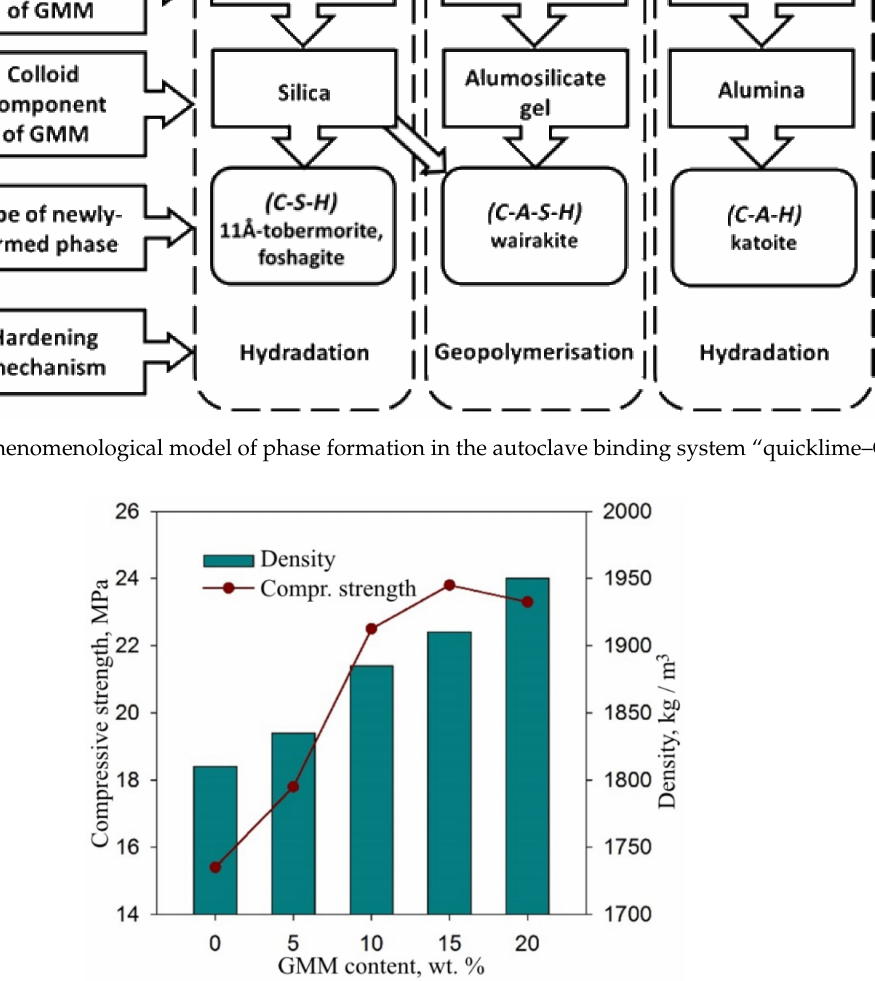
Figure 14. Physicomechanical properties of materials depending on the content of the